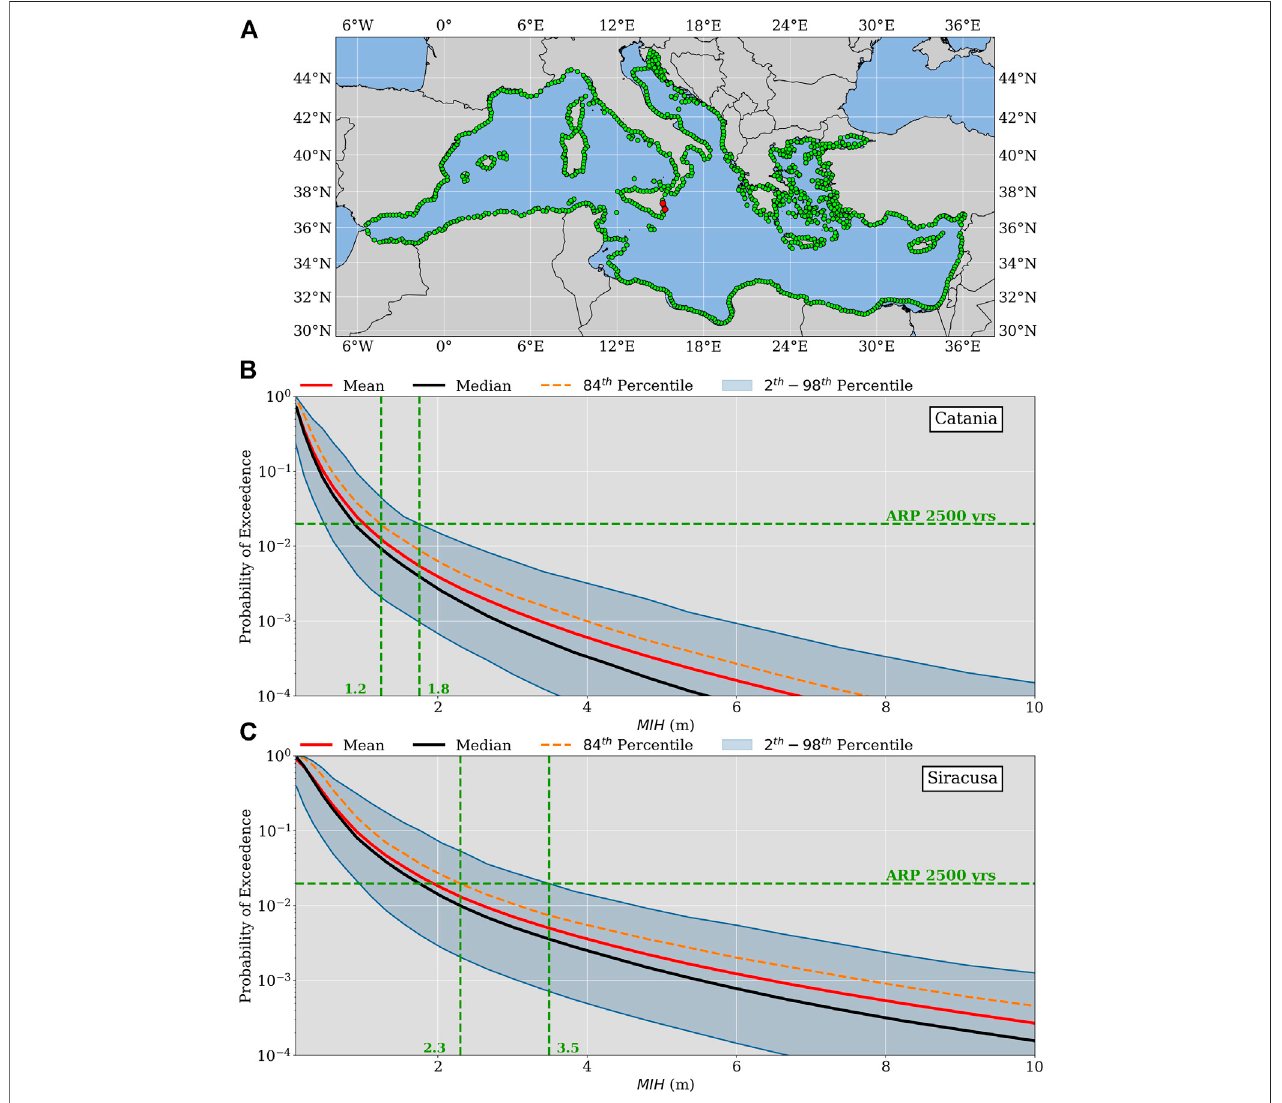
FIGURE1| Locationofthepointsofinterest(POIs,greendots)intheNEAMTHM18tsunamihazardmodelfortheMediterraneanareaonly[panel (A) ]:thetwoPOIs in front of Catania and Siracusa, used for the present case-study, are highlighted (red dots); the corresponding hazard curves [Catania, panel (B) , and Siracusa, panel (C) ,respectively]areshownfordifferentquantities:themean(redline),themedian(blackline),the84thpercentile(orangeline)andtheinterval2nd – 98thpercentiles(blue area). For both POIs, MIH never exceeds 4 m for an average return period of 2,500 years (green lines). The curves can be downloaded from the NEAMTHM18 interactive hazard curve tool (http://www.tsumaps-neam.eu/neamthm18/).